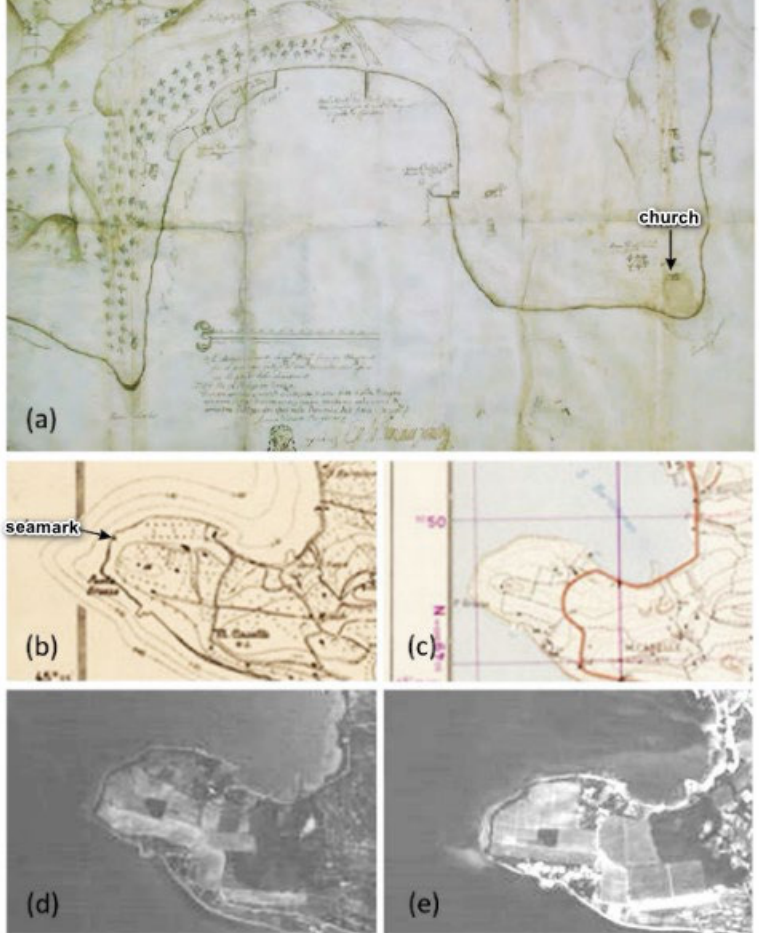
Figure 7. Historical maps and aerial images of Debeli Rti č /Punta Grossa: ( a ) The 1756 Visconti map of the San Bartolomeo Bay with the votive church identified; ( b ) excerpt of the 1916 topographical map at 1:25.000 map of the Italian Military Institute (IGM) with the seamark identified; ( c ) excerpt of the 1959 topographical map at 1:25.000 map of the Italian Military Institute (IGM); ( d ) Debeli Rti č in the 1957 aerial image; ( e ) Debeli Rti č in the 1984 aerial image.